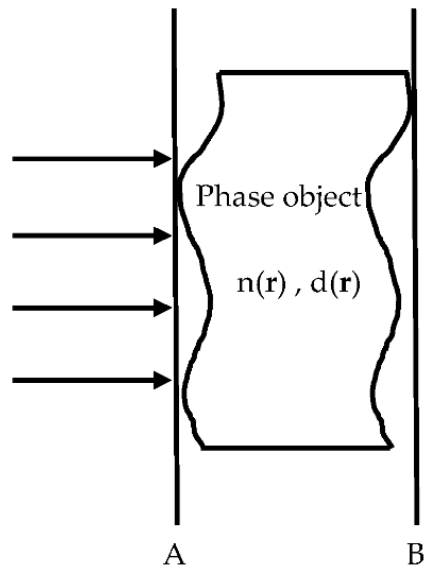
Figure 1. The volume